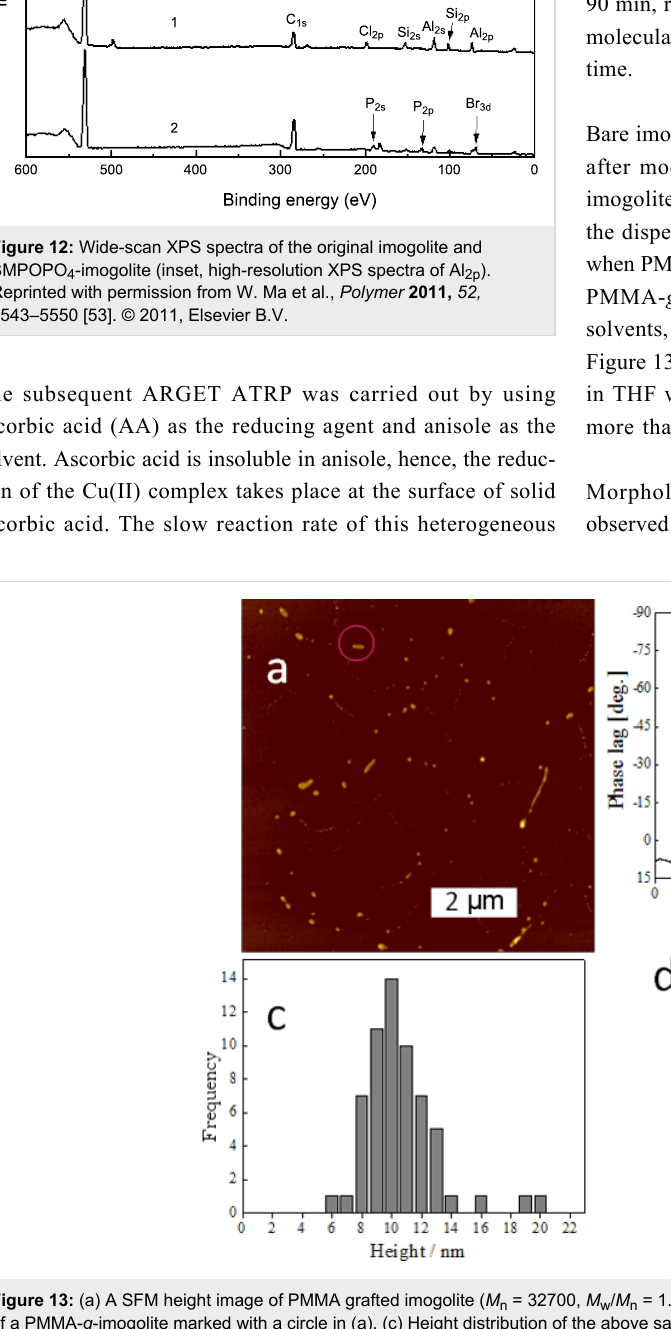
Figure 13: (a) A SFM height image of PMMA grafted imogolite ( M n = 32700, M w / M n = 1.33). (b) A phase image (insert) and cross-sectional analysis of a PMMA- g -imogolite marked with a circle in (a). (c) Height distribution of the above sample as estimated by SFM. (d) Photographs of the THF dispersion of the same sample with a concentration of 10 mg mL − 1 (the one on the right shows scattering of a green light beam by the dispersion due to the Tyndall effect). Reprinted with permission from W. Ma et al., Chem. Commun. 2011, 47, 5813–5815 [40]. © 2011, The Royal Society of Chem- istry.